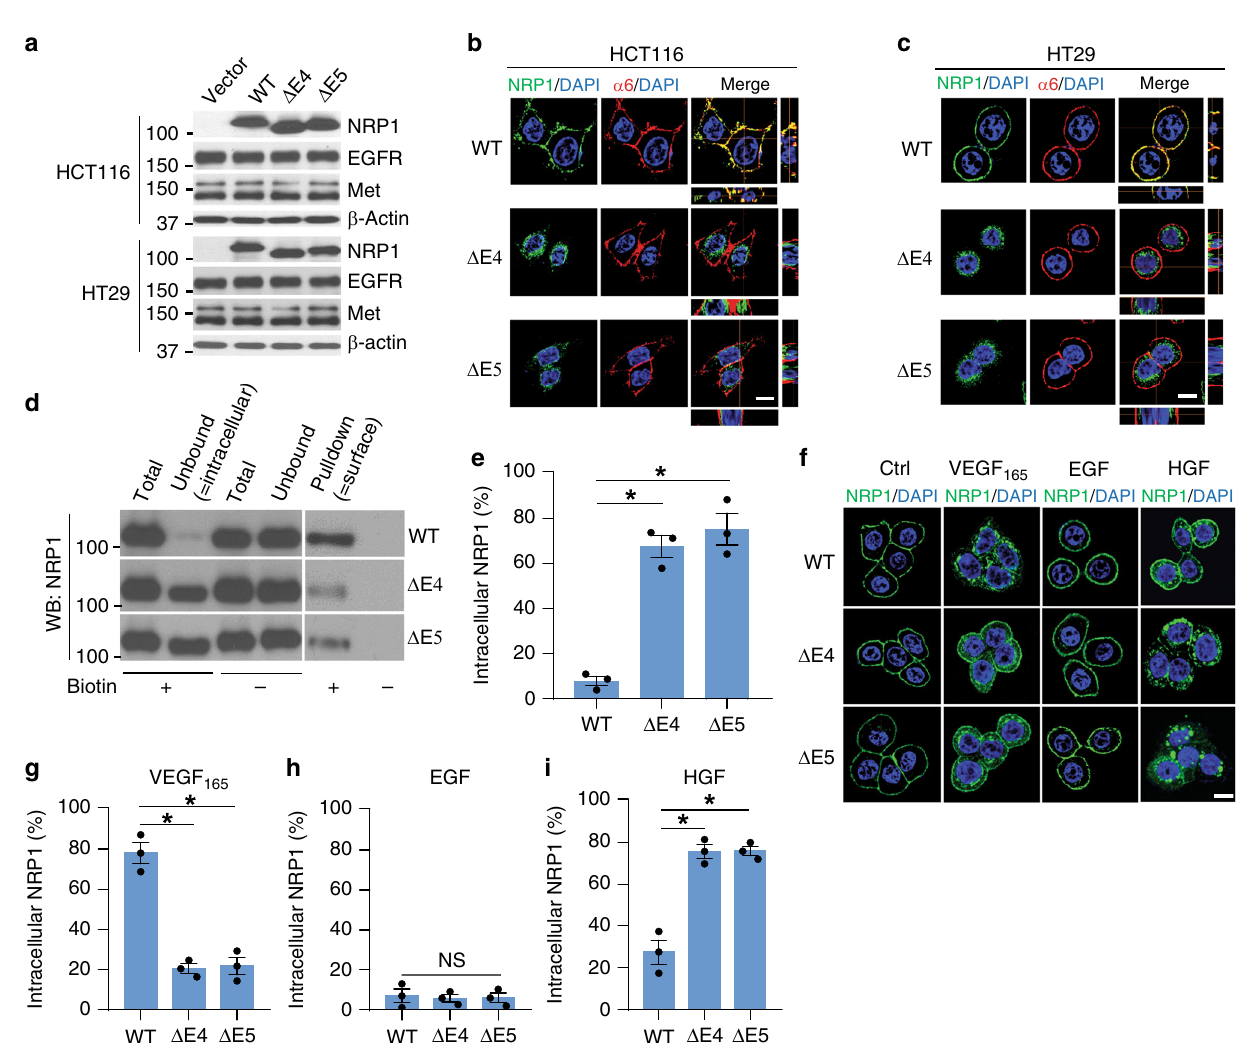
Fig. 2 NRP1- Δ E4 and NRP1- Δ E5 accumulate in intercellular compartments. a HCT116 and HT29 cells with stable expression of NRP1-WT, NRP1- Δ E4, NRP1- Δ E5 or vector control were assessed by western blot analysis. b , c Confocal images and z-stack projections of transverse sections of HCT116 b and HT29 c cells expressing the indicated NRP1 isoforms, stained for NRP1, α 6-integrin and DAPI. Scale bars, 10 µ m. d HT29 cells with expression of the indicated NRP1 isoforms were surface-biotinylated, then the biotinylated proteins were pulled down by streptavidin beads. The total sample before pulldown (total), the supernatant corresponding to the intracellular fraction (unbound) and the surface fractions (bound) were analyzed by western blot for NRP1. e The percentage of intracellular NRP1-WT and the variants was calculated as a ratio of the total. f Confocal images of NRP1 with DAPI staining in serum-starved HT29 cells with expression of the indicated NRP1 isoforms, stimulated with VEFG 165 (50 ngml − 1 ), EGF (50 ngml − 1 ), HGF (50 ngml − 1 ) or PBS as control for 30 min. Scale bars, 10 µ m. g – i The percentage of intracellular NRP1 staining upon stimulation with VEFG 165 , EGF or HGF as shown in f . All graphic data are presented as mean ± s.e.m. ( n = 3 independent experiments). * p < 0.002; NS not signi fi cant using Student ’ s t